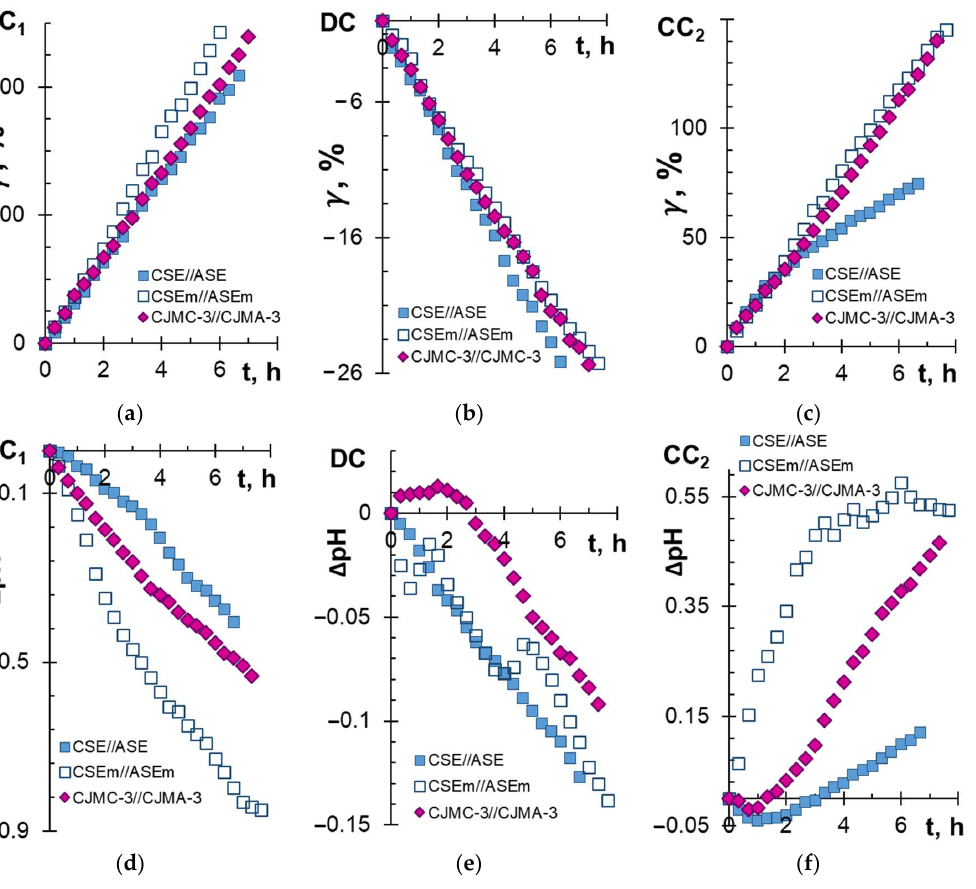
Figure 2. Degrees of concentration ( a , c ) and demineralization ( b ) of solutions, as well as the difference between the current and initial pH values ( d – f ) in the CC 1 ( a , d ), DC ( b , e ) and CC 2 ( c , f ) circuits vs. the ED duration of the model solution. Data are presented for CC 1 , DC and CC 2 formed by membranes CJMC-3 and CJMA-3, CSE and ASE, and CSEm and ASEm.